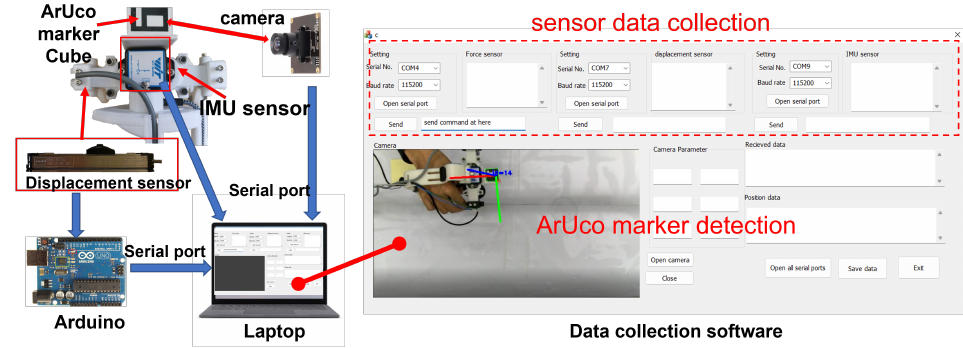
Figure 5. The data collection